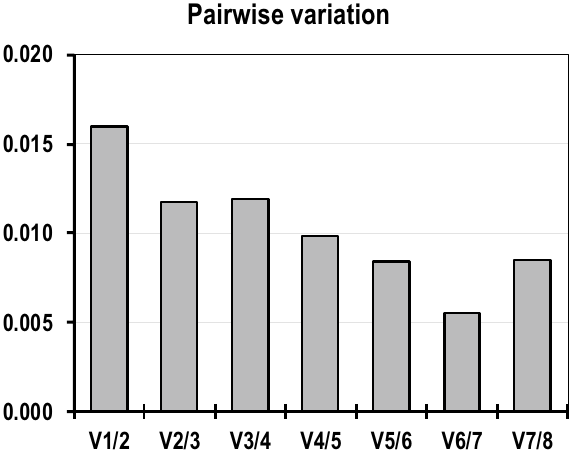
Figure 5. Optimal number of reference genes for normalization in antler blood samples of both young and adult red deer. A pair-wise variation (Vn/n + 1) analysis was used to determine the optimal number of reference genes required for accurate normalization. A value < 0.15 indicates that the use of additional reference genes would not markedly improve